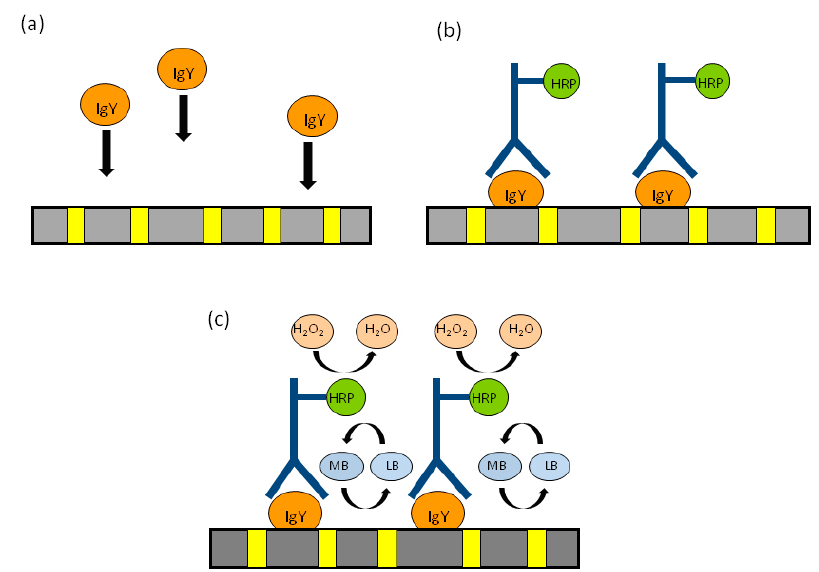
Figure 13. Schematic representation of the analytical protocol used to detect immunoglobulin IgY, extracted from tempera paints. MB and LB are the oxidized and reduced forms of the redox mediator methylene blue and HRP is horseradish peroxidase, used as enzymatic label for the anti-IgY antibody ( a ) capture of immunoglobulin IgY on the polycarbonate of the NEE; ( b ) molecular recognition by anti-IgY labeled with HRP; ( c ) generation of the electrocatalytic cycle by adding the enzyme substrate H 2 O 2 and the mediator MB. (reprinted with permission from [109]).